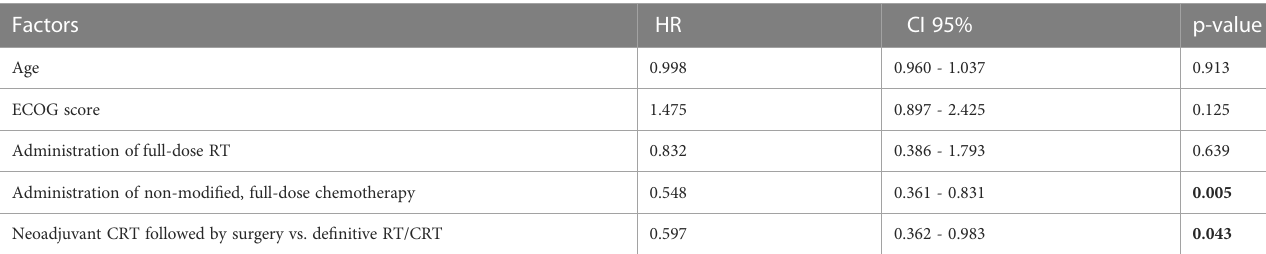
TABLE 3B Multivariate analysis of clinical parameters regarding progression-free survival (PFS) of esophageal SCC in elderly patients after de fi nitive or neoadjuvant CRT/RT. Factors